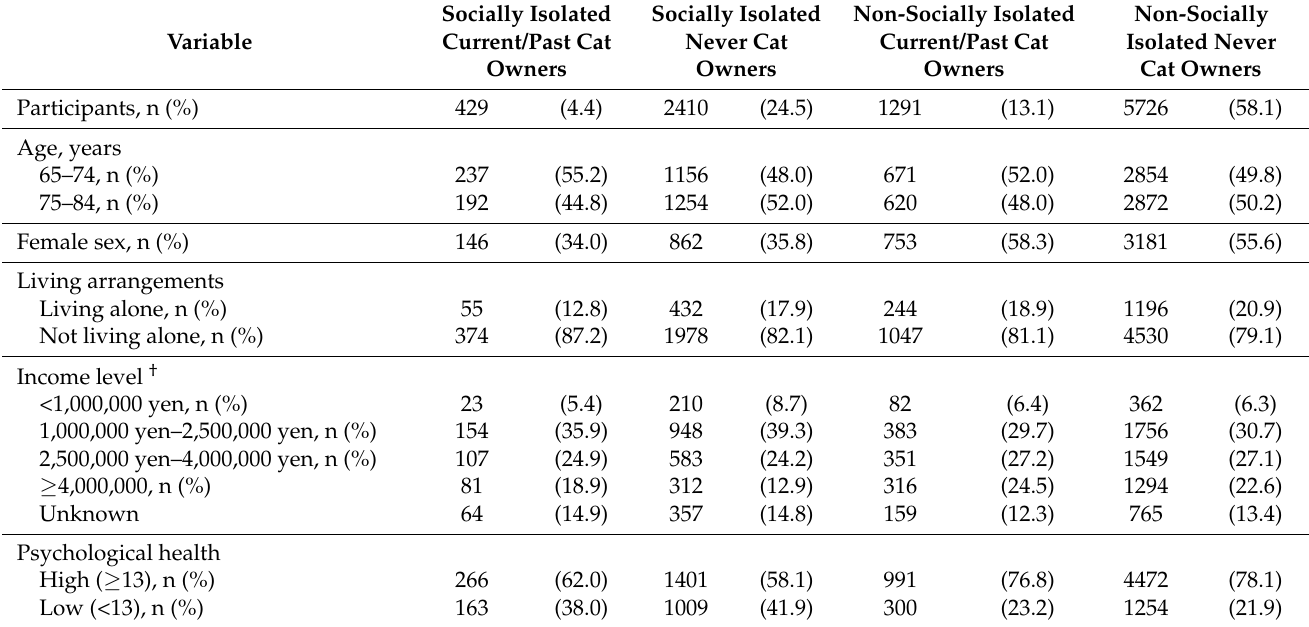
Table 2. Demographic characteristics of 9856 socially and non-socially isolated community-dwelling older adults with or without experience of cat